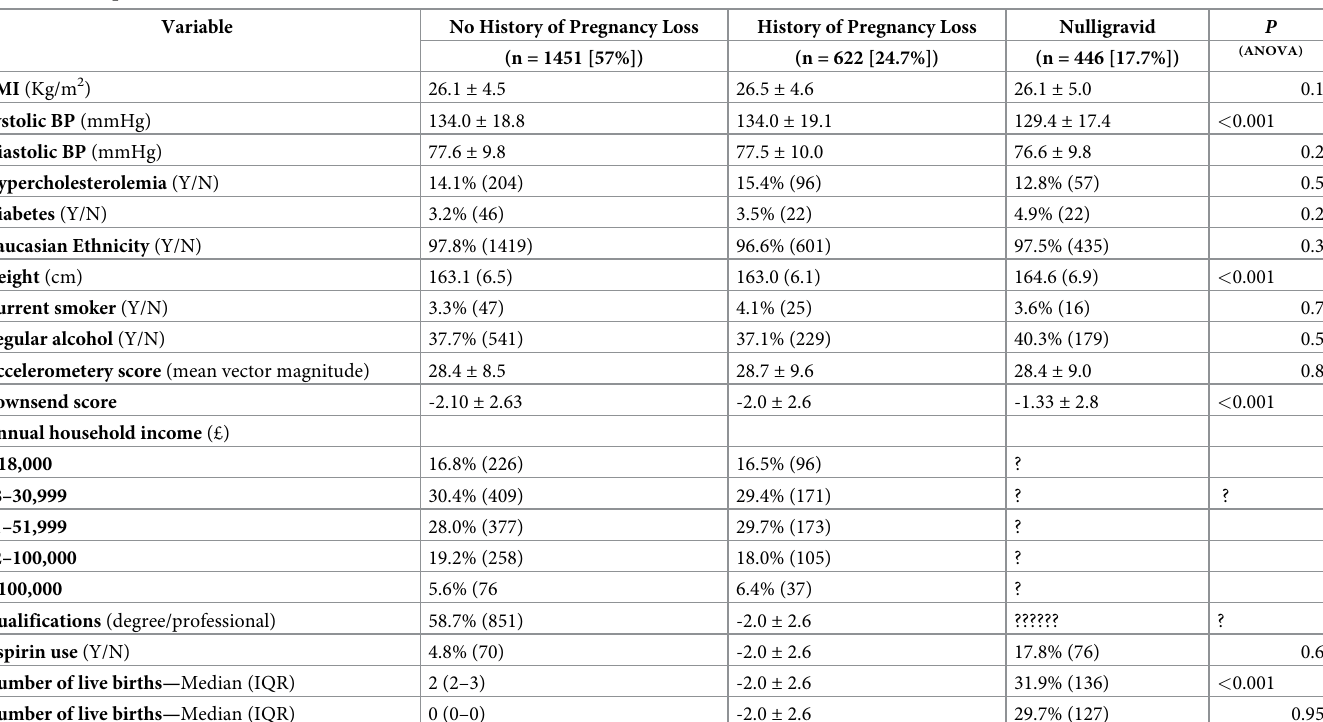
Table 1. Participant